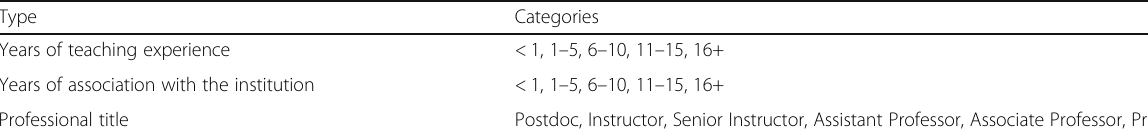
Table 2 Type of demographic data collected for the seven STEM